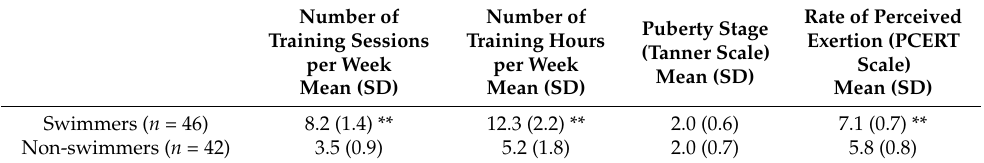
Table 1. Training loads, puberty stage and rate of perceived exertion in the examined groups.